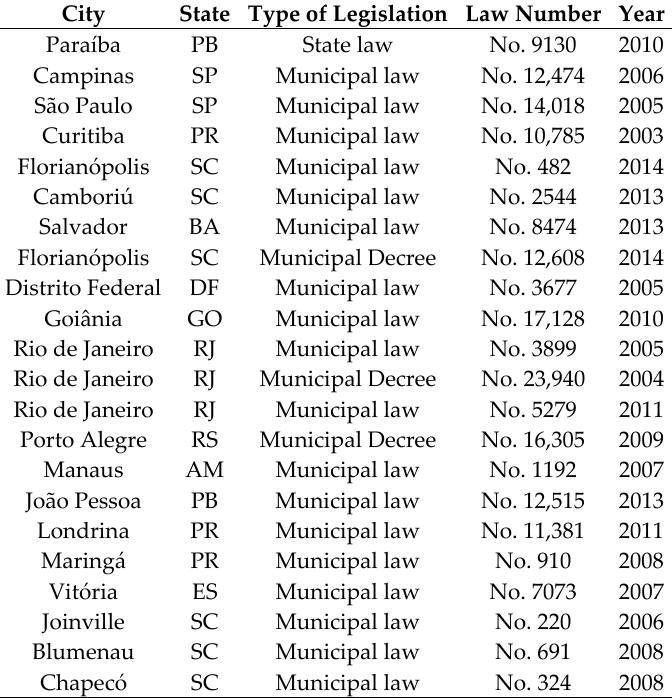
Table 4. List of legislations